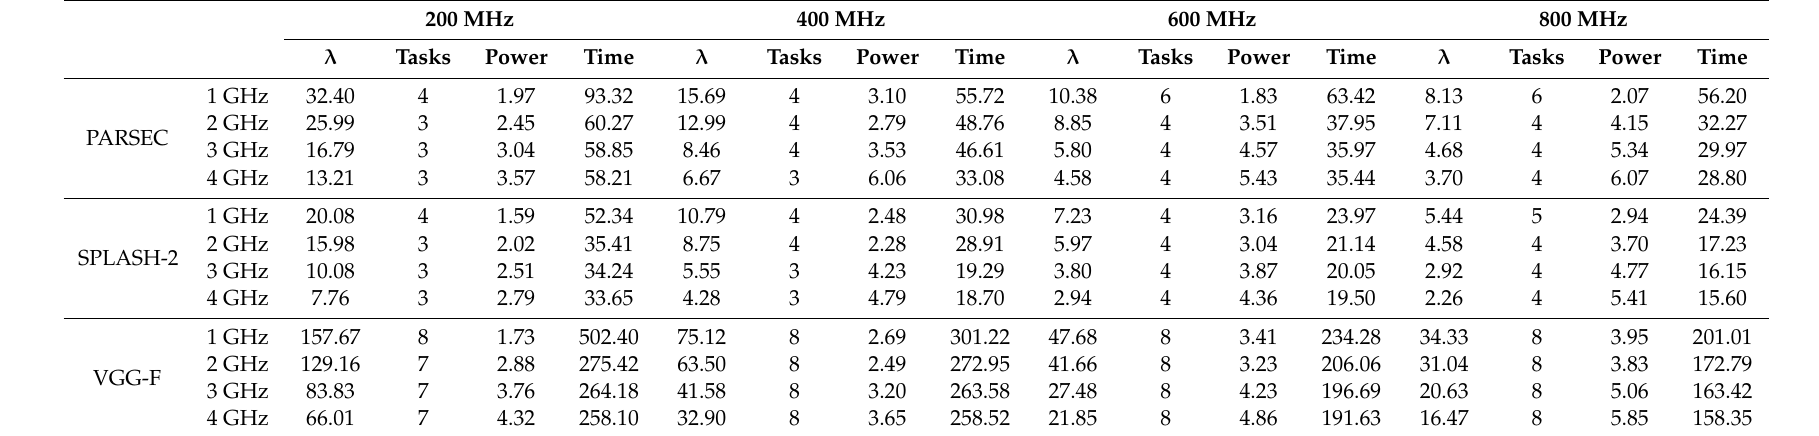
Table 2. The best o ffl oading point from the actual data and its power-time